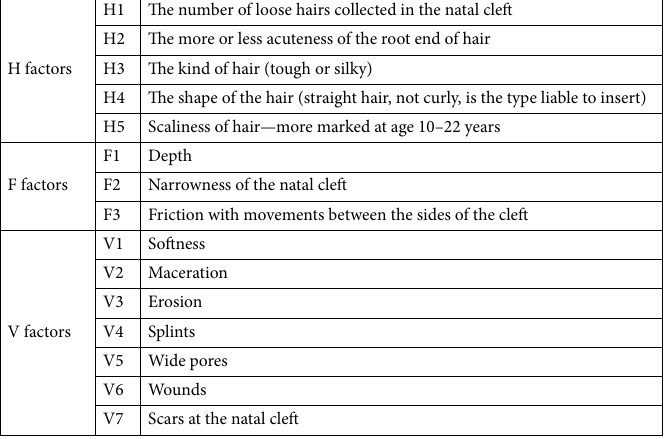
(Table 2) and provided consistent evidence of a lower sweat response in PSD patients (11.9 µl [6.0–24.0]) than matched controls (18.6 µl [8.9–32.3], p = 0.005, Fig. 2B). Likewise, the linear regression model including all 459 patients with complete data on all of the potentially confounding covariates (age, sex, BMI and exercise) showed